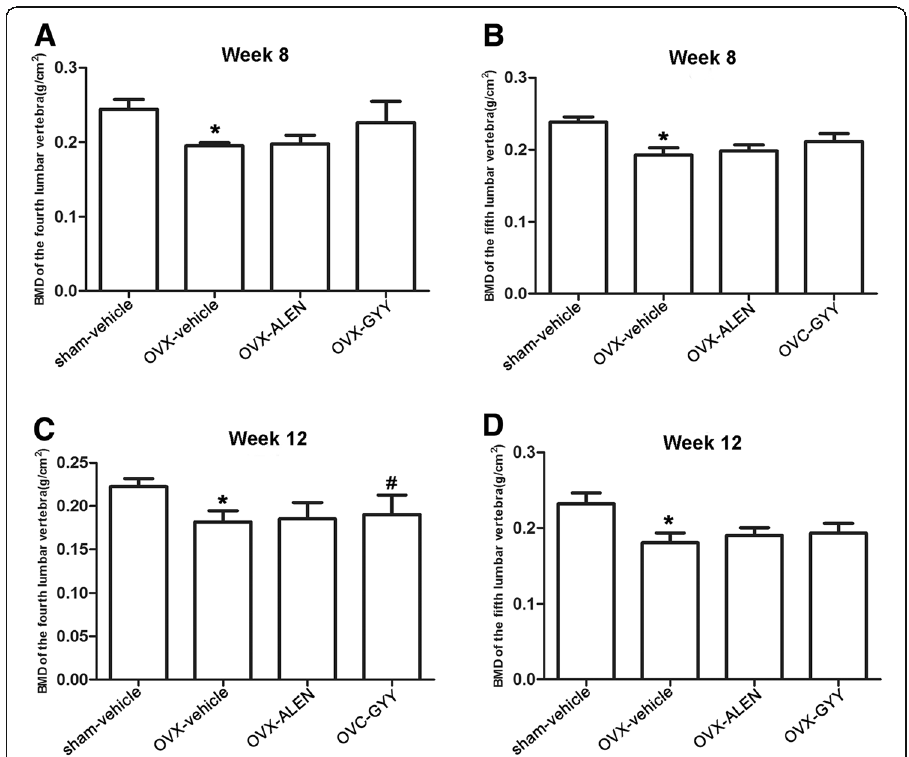
Fig. 4 The results of the bone density test for the lumbar vertebrae. The BMD measurements are for: the fourth lumbar vertebra in week 8 ( a ); the fifth lumbar vertebra in week 8 ( b ); the fourth lumbar vertebra in week 12 ( c ); the fifth lumbar vertebra in the week 12 ( d ). The results for the OVX-vehicle group were compared with those for the sham-vehicle group ( p <0.05) and OVX-GYY group ( p <0.05). * p <0.05 vs. sham-vehicle group; # p <0.05 vs. OVX-vehicle group. OVX-vehicle: ovarectomized rats treated with vehicle; OVX-ALEN: ovarectomized